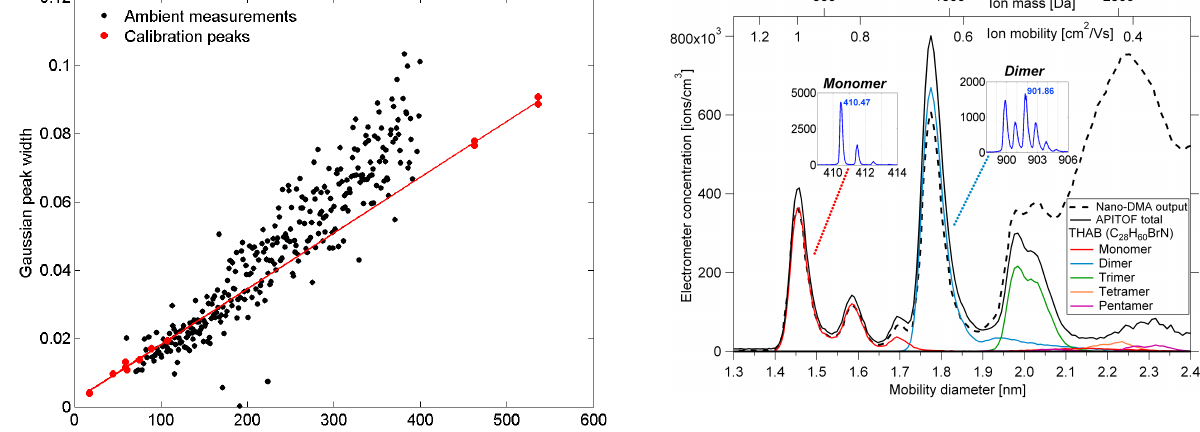
Fig. 5. An electrometer sampled in parallel with the APi-TOF be- hind a nano-DMA sampling electrosprayed tetra-heptyl ammonium bromide (THAB). The DMA scanned the over the size range in the figure, and the total ion count exiting the DMA is plotted as a black dashed line, with the total APi-TOF count plotted as the solid black line. Lines of other colours are the signals in the APi-TOF from different clusters of THAB. The monomer and dimer isotopic dis- tributions are also shown. The factor of 1000 difference is due to losses inside the APi-TOF. At m/Q> 1000Th the transmission falls off even more. For comparison, the horizontal scale is depicted in both mass, mobility, and mobility